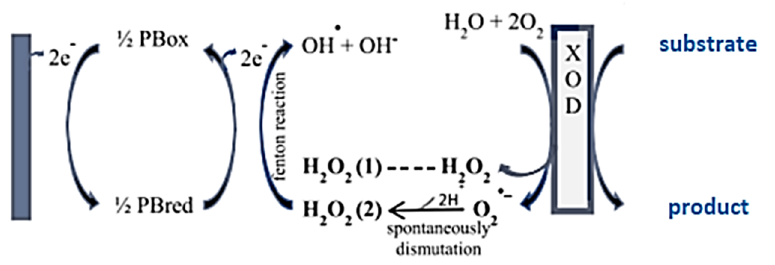
Figure 1. Principle of detection using XOD based biosensor, using Prussian Blue (PB), as mediator.